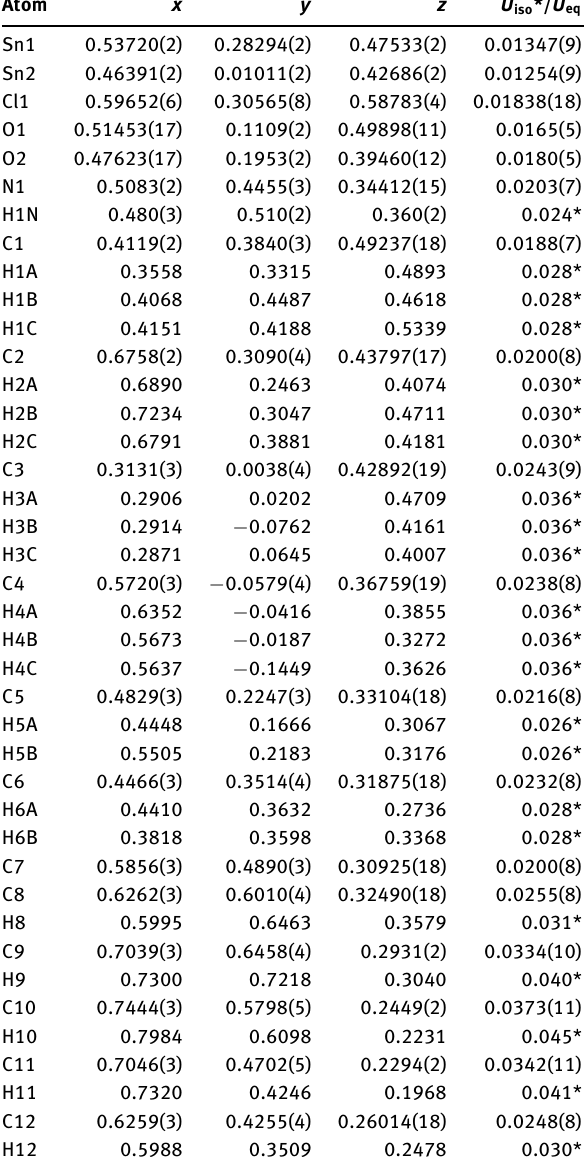
Table 2: Fractional atomic coordinates and isotropic or equivalent isotropic displacement parameters (Å 2